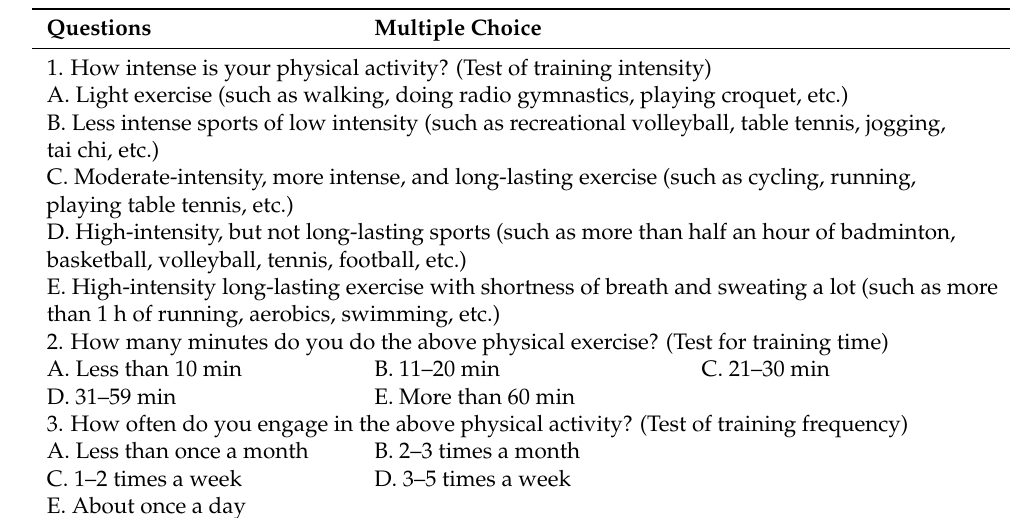
Table 1. Questionnaire on the physical exercise of primary school